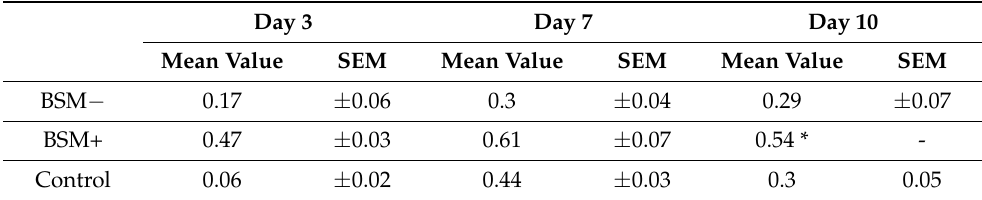
Table 3. Cell Proliferation: MTT assay, absorbance at 570 nm for BSM − (cerabone ® ), BSM+ (cerabone ® Plus including HA) and the control (HOB alone) on days 3, 7 and 10. The mean values are for parametric data and the median values (*) are for non-parametric data.